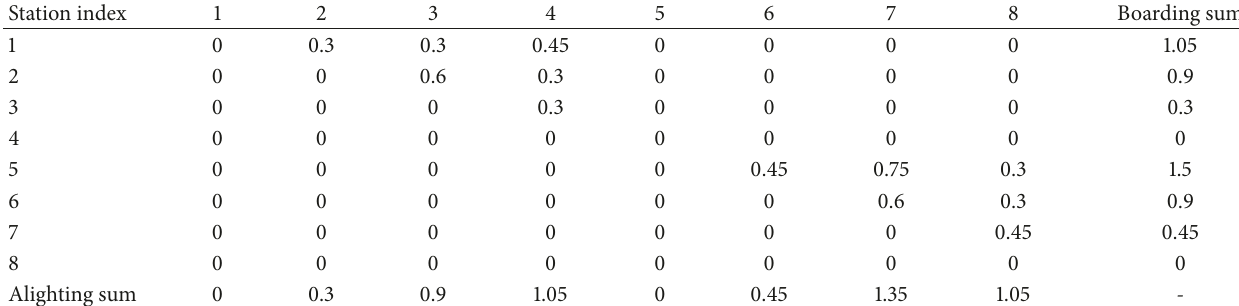
Table 4: Baseline passenger demands for a short metro line (passengers per second).